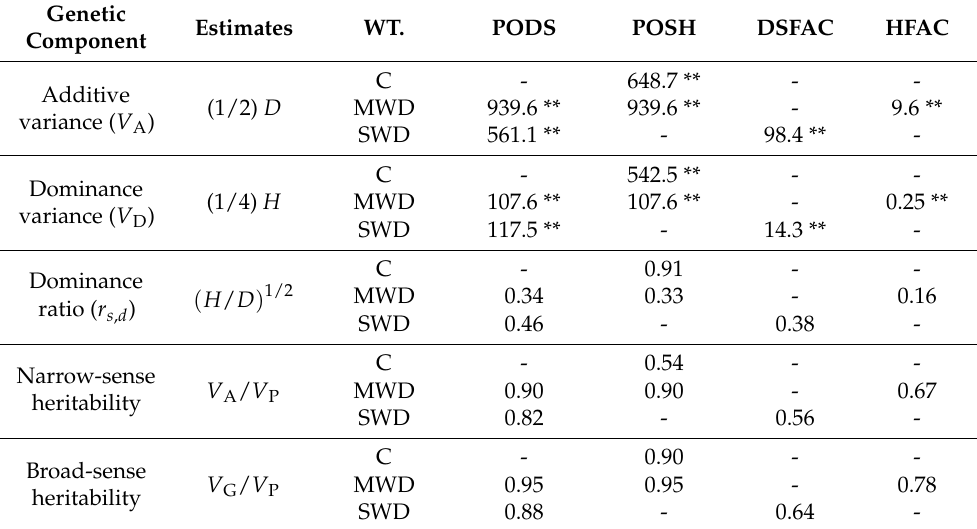
Table 6. Estimates of components of variation and heritabilities for PODS, POSH, DSFAC, and HFAC